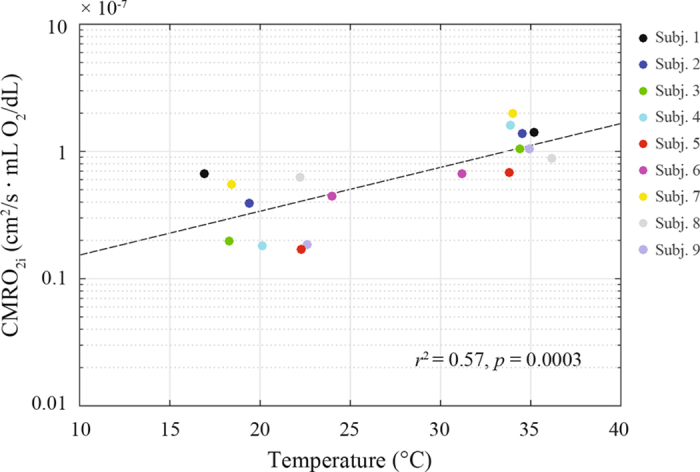
Effect of temperature on CMRO2i during CPB.